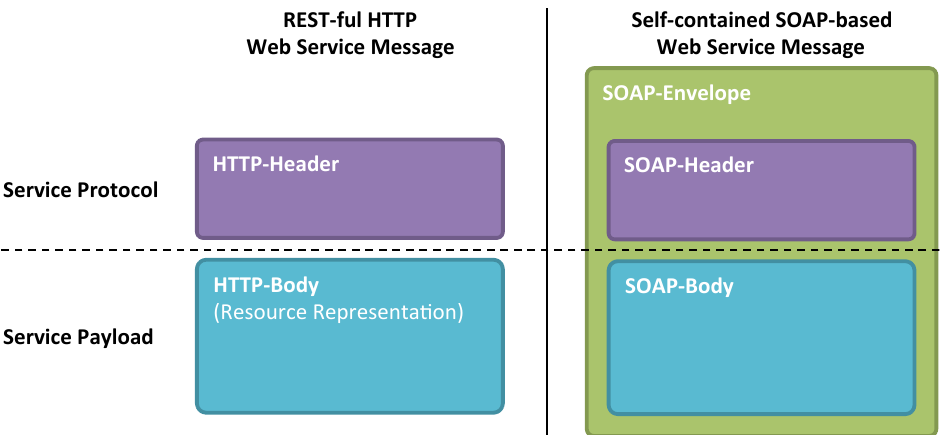
Figure 7. Comparison of the SOAP-based service message structure with a REST service message structure exemplified by a REST-ful HTTP